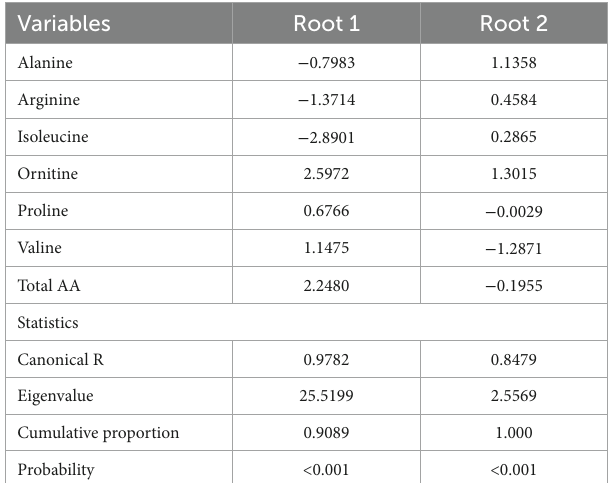
variance. The coefficients obtained for each variable are presented in Table 4. A larger coefficient corresponds to a greater contribution of the respective variable to the discrimination between groups. For